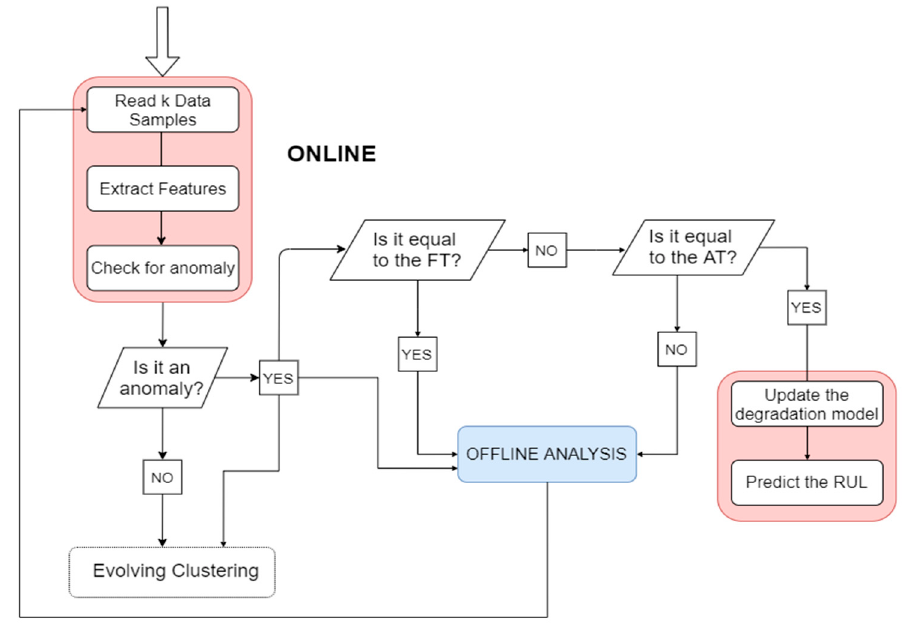
Figure 3. The proposed methodology for the prognostic health management (PHM) implementation after fault identification.